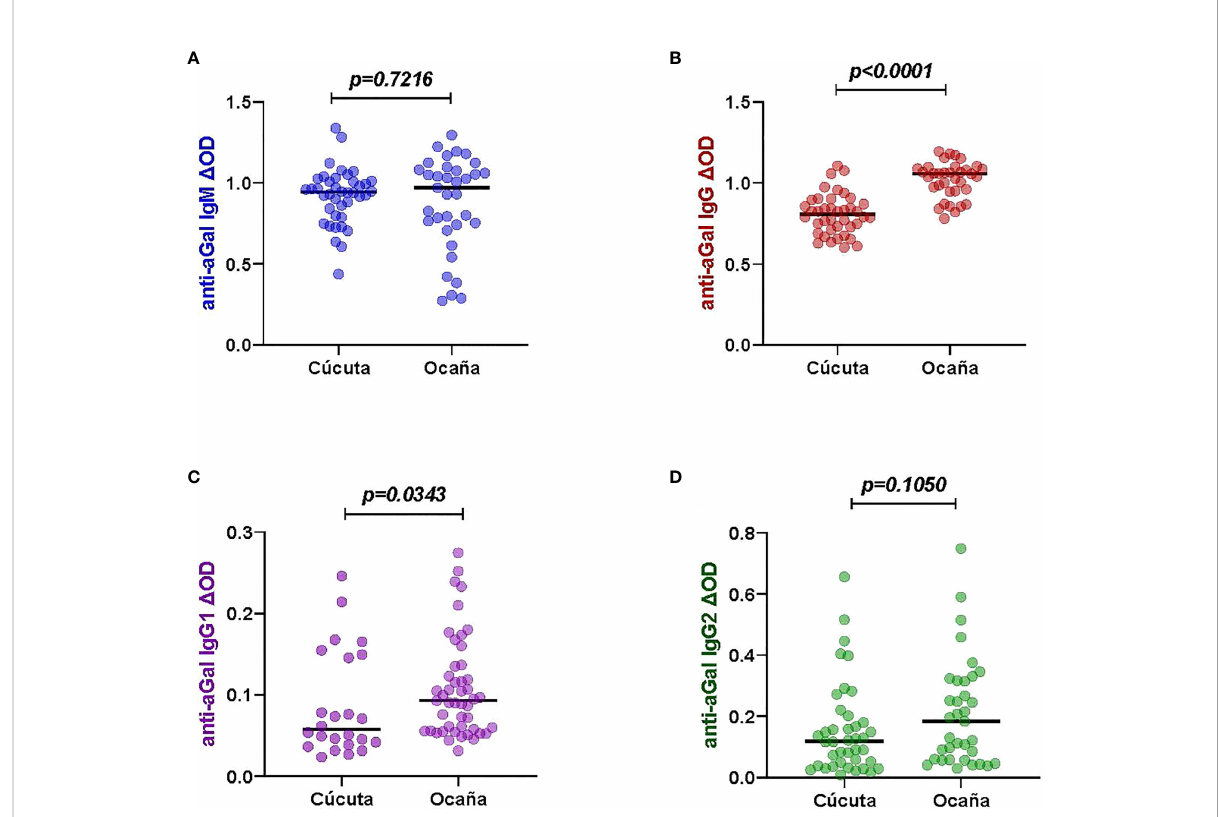
FIGURE 3 Speci fi c anti-aGal IgM, IgG, IgG1 and IgG2 levels by patient locations with different hospital levels; Cu ́ cuta (n=40) and Ocaña- (n=35). (A) Blue color - anti-aGal IgM antibody levels. (B) Brown color - anti-aGal IgG antibody levels. (C) Purple color - anti-aGal IgG1 antibody levels. (D) Green color - anti- aGal IgG2 antibody levels. Individual anti-aGal antibody levels are represented by the colored dots and horizontal black lines represent medians of group individual antibody responses. Antibody levels are measured in units of OD (optical density). “ p ” values <0.05 were measured using the pairwise non- parametric Mann-Whitney